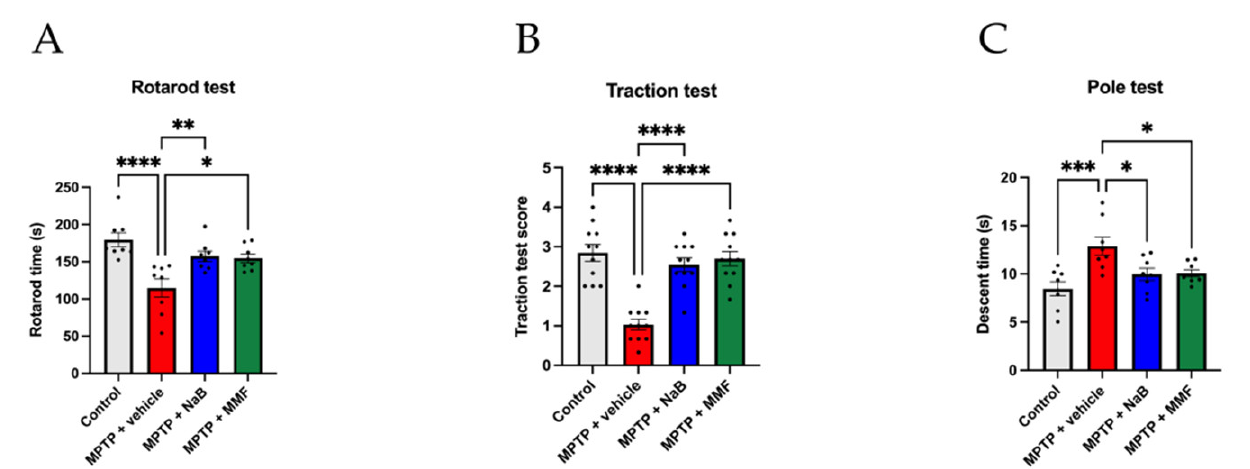
Figure 3. NaB and MMF alleviate motor dysfunctions of the MPTP-induced PD mice. ( A ) Rotarod test. ( B ) Traction test. ( C ) Pole test. (n = 8–11). Data are presented as mean ± SEM. * p < 0.05, ** p < 0.01, *** p < 0.001, **** p < 0.0001 versus the MPTP + vehicle group.